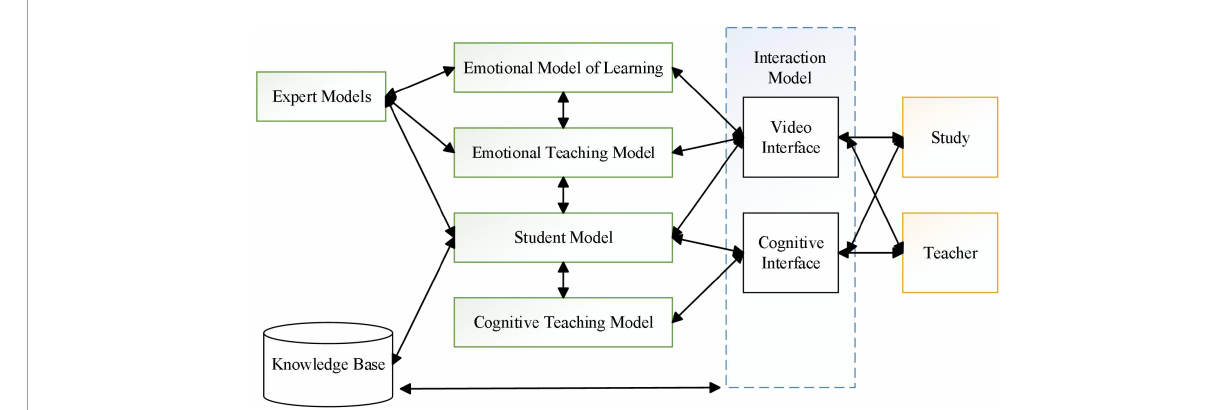
FIGURE3 Functional knot of the intelligent emotion network assessment system.